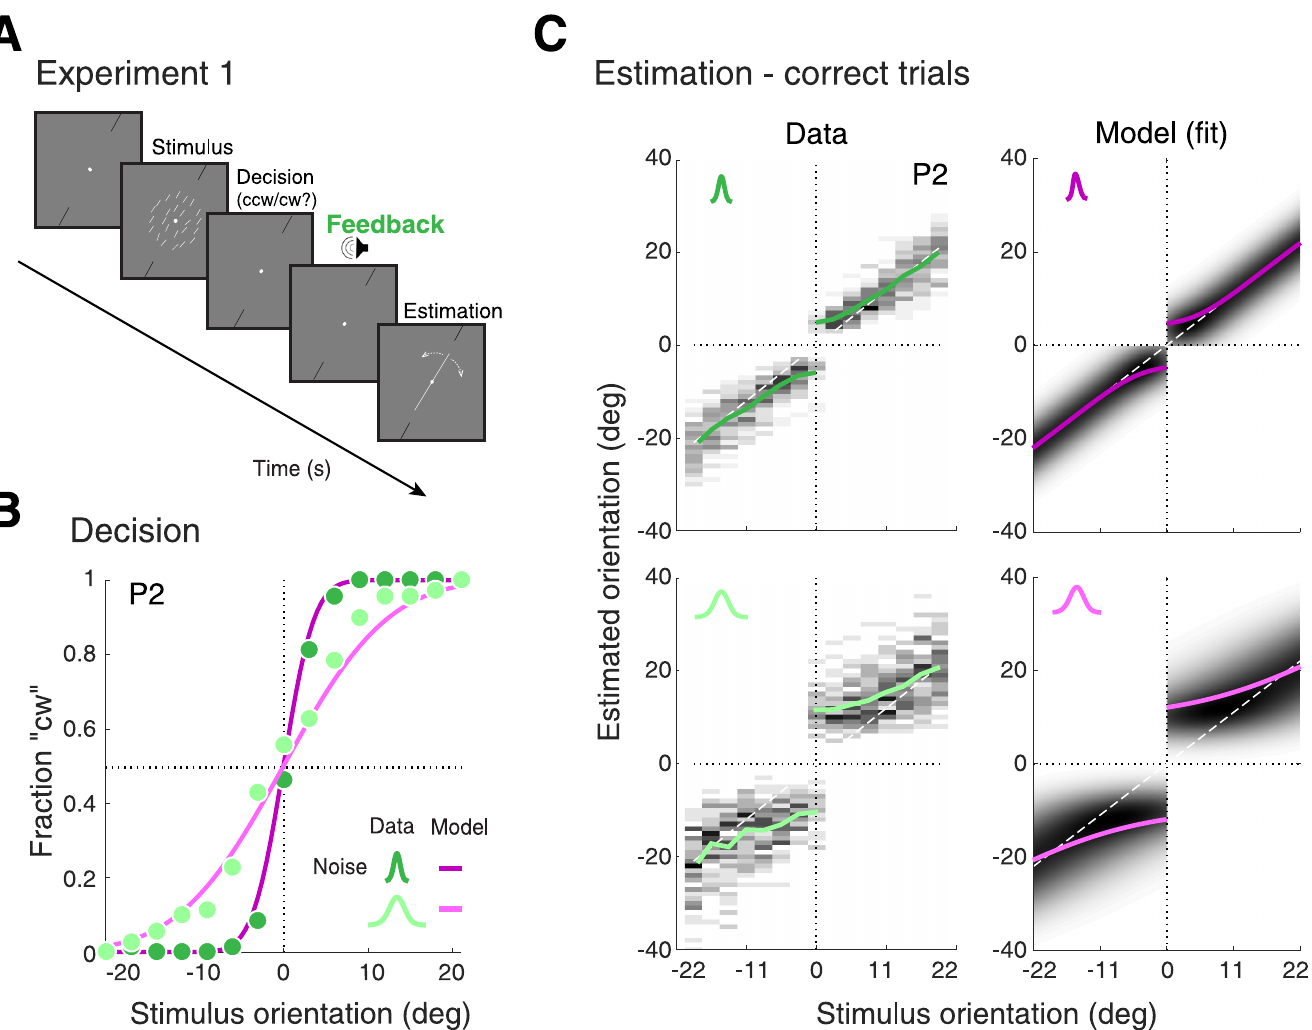
Fig 3. Experiment 1—Data and model fits for correct trials. (A) The stimulus consisted of an array of line segments whose orientations were sampled from a Gaussian centered at the stimulus orientation θ . Stimuli had one of two levels of noise corresponding to different widths of the Gaussian ( σ s ≔ {3, 18} deg). Stimulus orientation was uniformly distributed within a range ± 21 deg around the reference orientation. Subjects first reported whether the stimulus orientation was cw/ccw of the reference orientation (indicated by two black lines). 500 ms after reporting their decision, they received auditory feedback indicating whether their decision was correct or not. Instructed to take feedback into account, subjects then provided an estimate of stimulus orientation by adjusting a line cursor. (B) Categorical judgment data (green circles) and the self-consistent observer model fit (purple lines) for typical subject P2. Darker shades represent data/fit for lower stimulus noise. As expected, the slope of the psychometric function is steeper for a lower noise level. Stimulus orientation is relative to the reference orientation. (C) Estimate distributions and the predicted distributions of the fit model for typical subject P2 (colored lines represent mean estimates). Subjects show the characteristic repulsive bias away from the reference, confirming the results of previous studies [7, 8, 10]. Note that the model was jointly fit to the decision and estimation data. See S1 Fig for data and model fits of all other